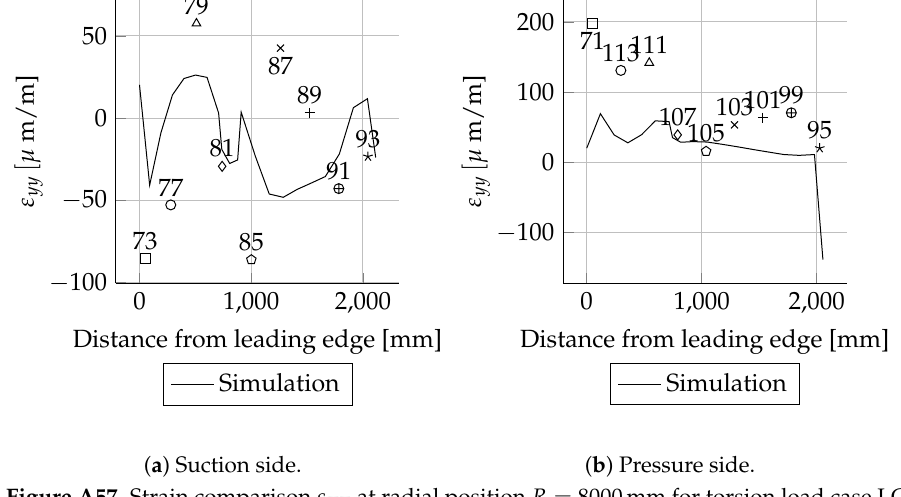
Figure A57. Strain comparison ε TT at radial position R = 8000mm for torsion load case LC_1.